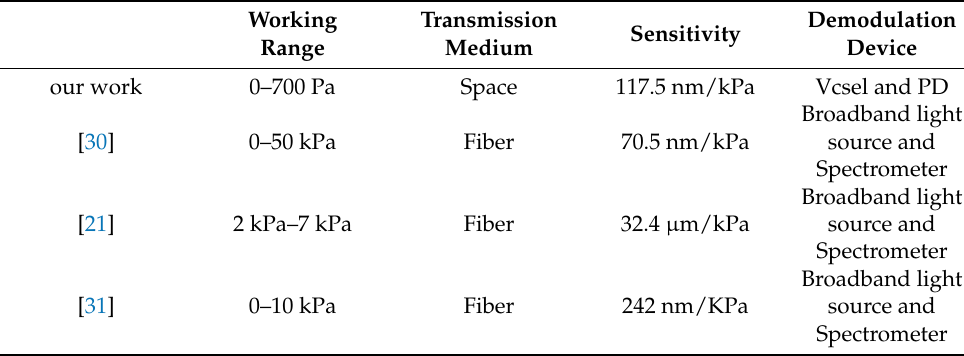
Table 1. Comparison with other optical pressure